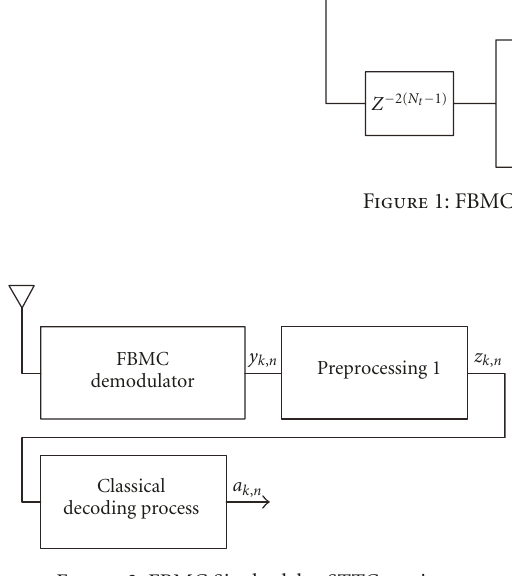
Figure 2: FBMC Single-delay STTC